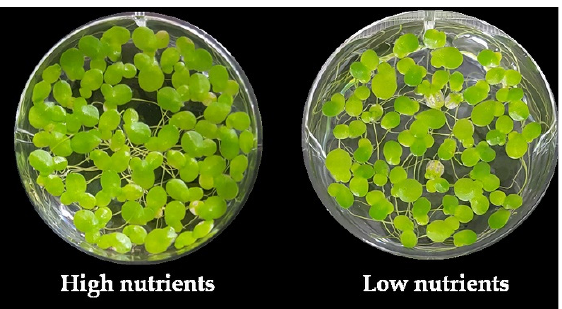
Figure 1. L. gibba plants grown under high and low total nitrogen and total phosphorus concentrations in nutrient solution. Table 1. The growth rate of L. gibba plants after a seven-day cultivation period in nutrient solu- tions with high and low total nitrogen and total phosphorus concentrations. Values shown are mean ± standard deviation of ten replicates ( n = 10). Different letters indicate significantly different values ( t -test, p ≤ 0.05).